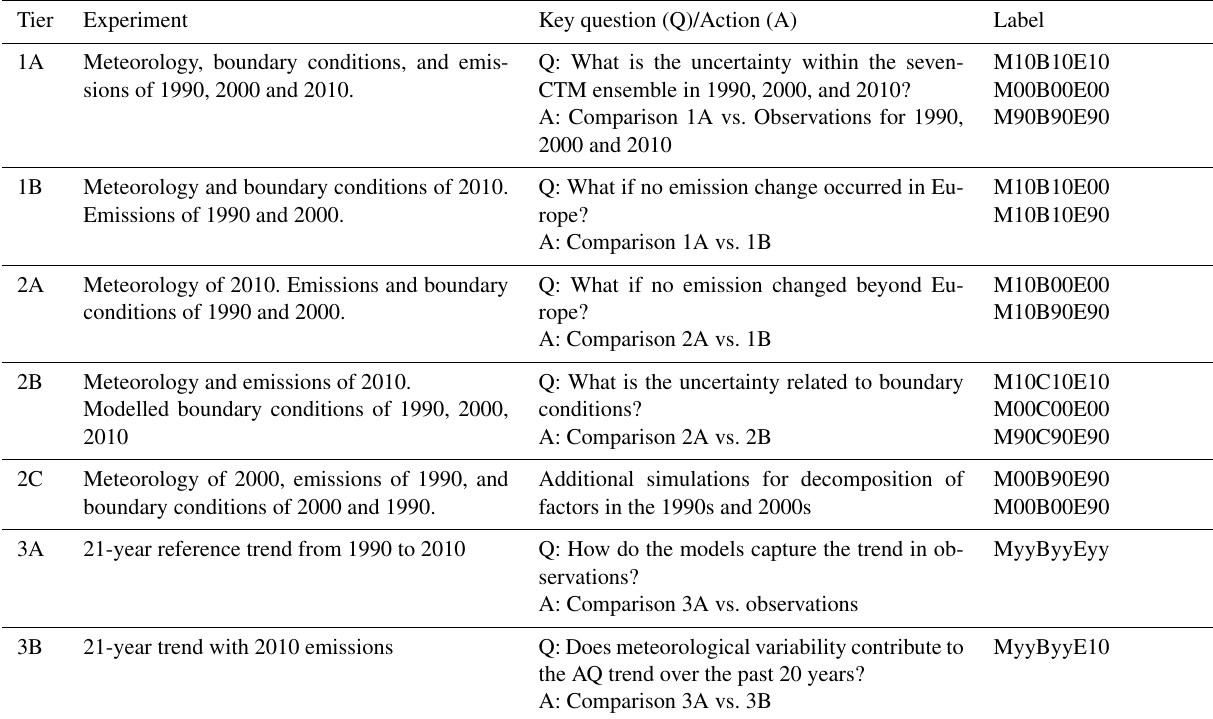
Table 2. Summary of model experiments (including label) with corresponding key scientific questions. The simulations are labelled Myy- ByyEyy where M indicates meteorology, B indicates observation-based boundary conditions, C indicates modelling-based boundary condi- tion, E indicates emission, and yy is the 2-digit reference to the corresponding year.